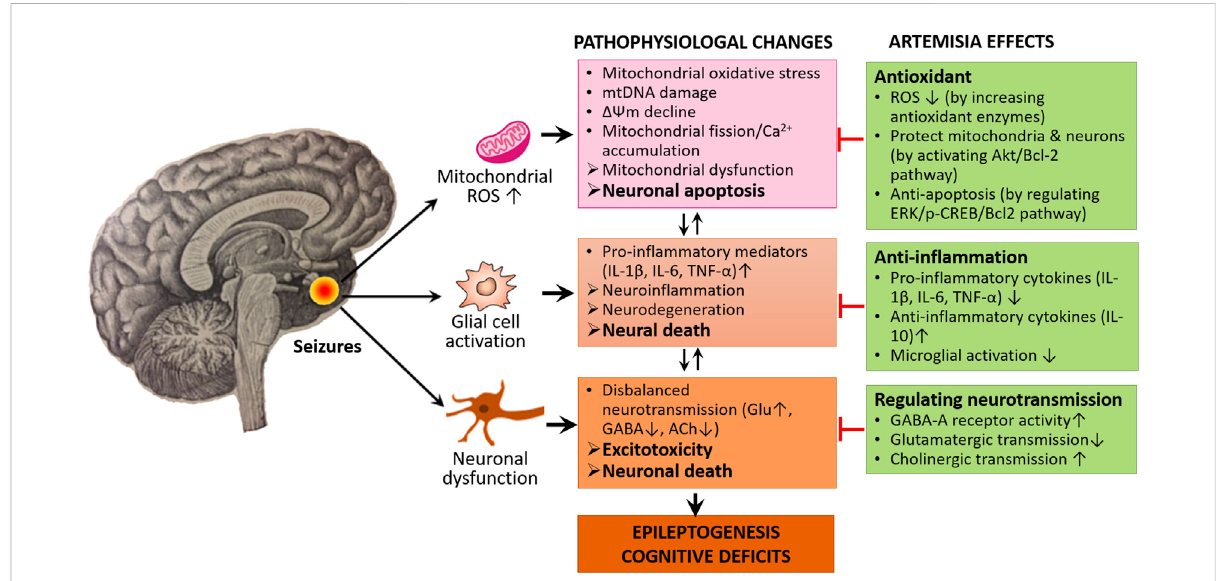
FIGURE 2 Neuroprotective mechanisms of Artemisia. Artemisia extracts exert their neuroprotective and anti-epileptogenic effects through the modulation of molecular signaling pathways involving ROSproduction and neuroin fl ammationas well as regulating disbalancedneurotransmission, thereby preventing excess neural death and apoptosis.